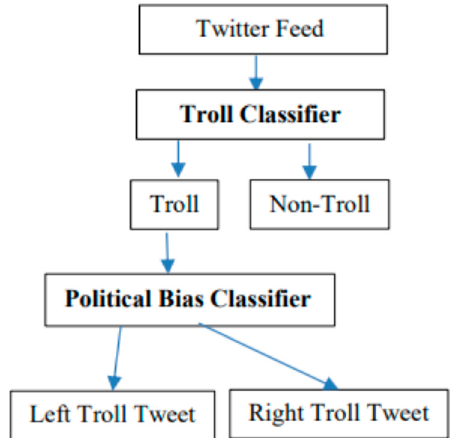
Figure 1. Process of classification consists of two steps. At first step, the troll tweets are recognized using “Troll Classifier”. In the second step, the “Political Bias Classifier” is used to recognize political orientation of previously recognized troll tweets, which can be left (Left Troll Tweet class) or right (Right Troll Tweet class) [8].